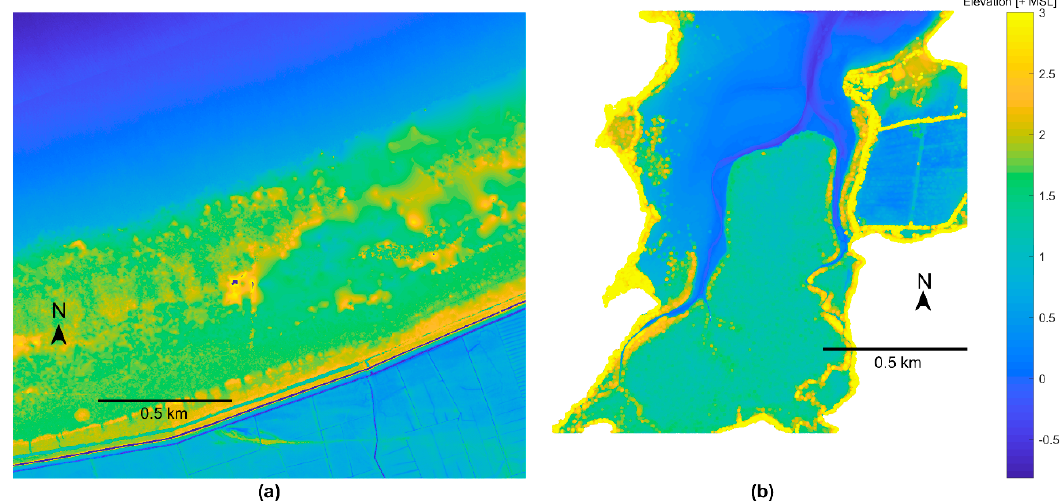
Figure 6. ( a ) The Firth of Thames LiDAR devoid of a channel network. Patchy higher elevations likely indicate a vegetation canopy; ( b ) Tauranga LiDAR data. Deep, incised channels and a level vegetated intertidal characterize the site. High elevation along channels displays a dense mangrove canopy. The color bar shows an elevation scale for both